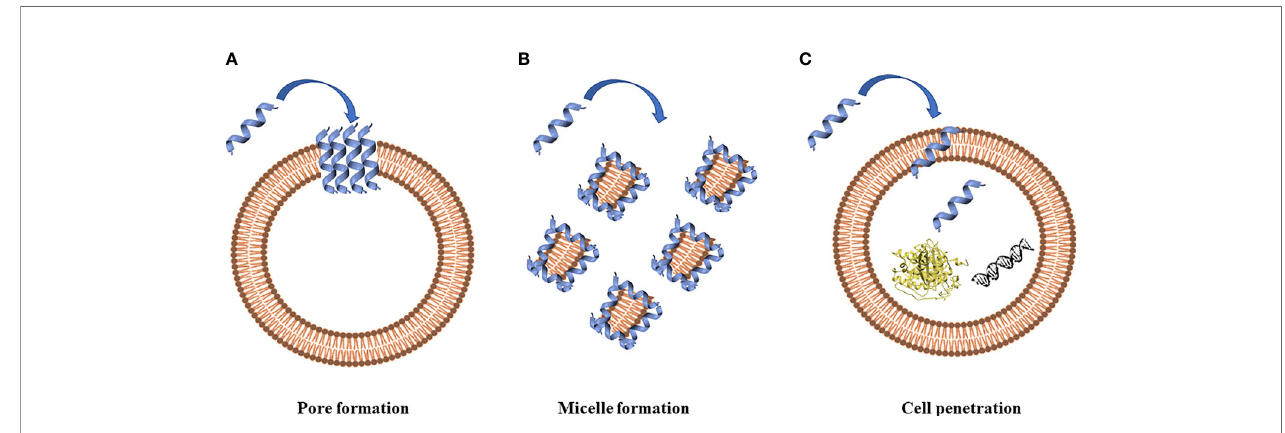
FIGURE 2 | Antimicrobial peptides can act through a membranolytic and non-membranolytic mechanism. In the membranolytic mechanism AMPs can lead to (A) pore formation on the cell membrane or (B) micelle formation on the cell membrane. In the non-membranolytic mechanism, (C) AMPs can penetrate cell membranes and interact with intracellular targets, such as DNA and proteins. Figure created with Biorender.com and UCSF CHIMERA software (Pettersen et al.,